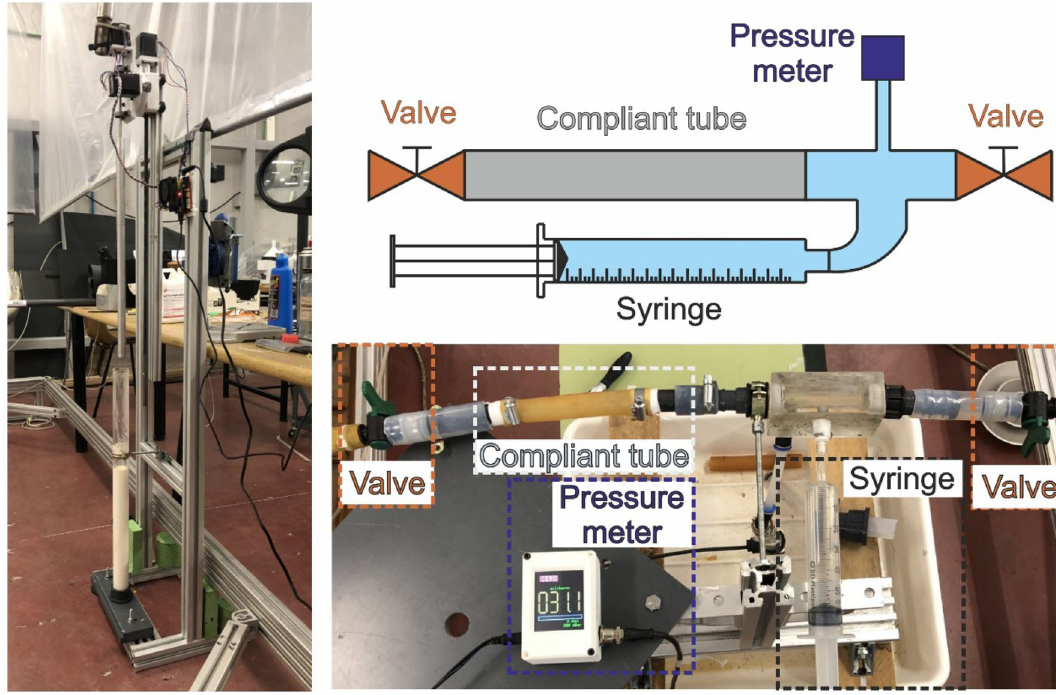
Figure 2. Latex tube manufacturing station (left) and compliance measurement setup